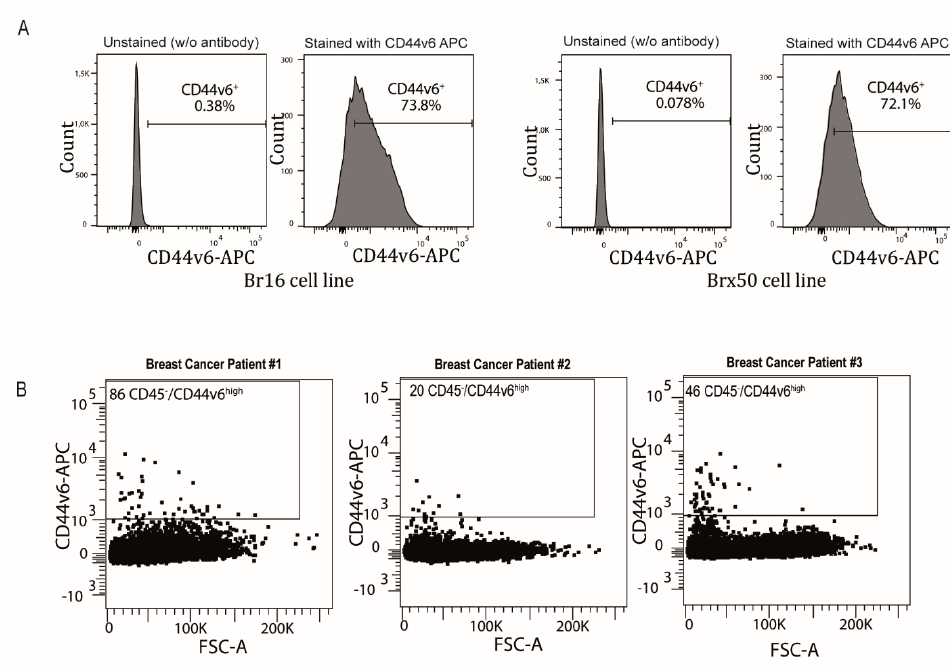
Figure 5. CD44v6 is also expressed in CTCs from breast cancer. ( A ) Plots demonstrating the high expression of CD44v6 in two established breast CTC lines: Br16 and Brx50. ( B ) FACS plots demonstrating the presence of CD45 - /CD44V6 high cells in the blood of patients with breast cancer ( n = 3). FSC stands for “forward scatter”. Overall, the data presented here strongly suggest that CD44v6 is a robust transmem- brane CTC candidate marker in colorectal, breast and potentially other cancers.